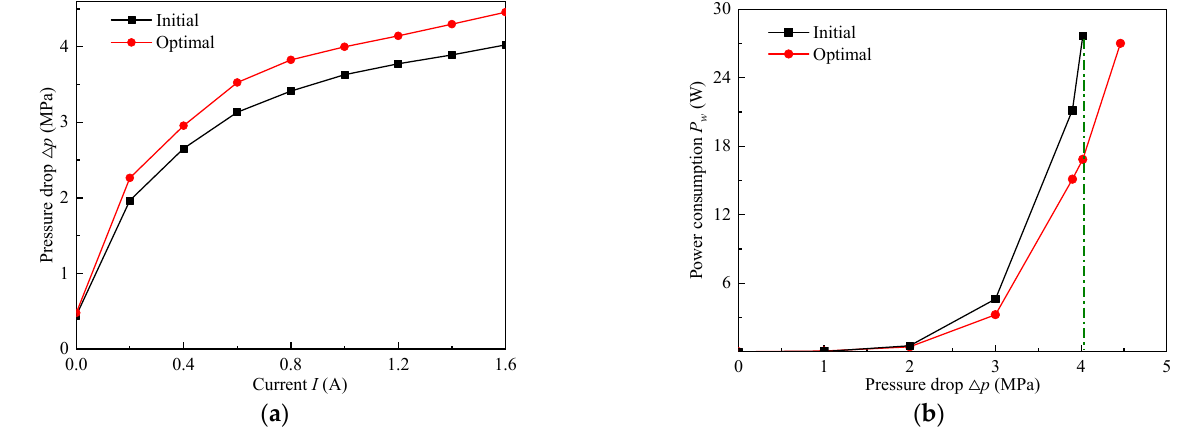
Figure 21. Comparison of the initial and optimal performance indicators: ( a ) pressure drop Δ p , ( b ) power consumption P w.